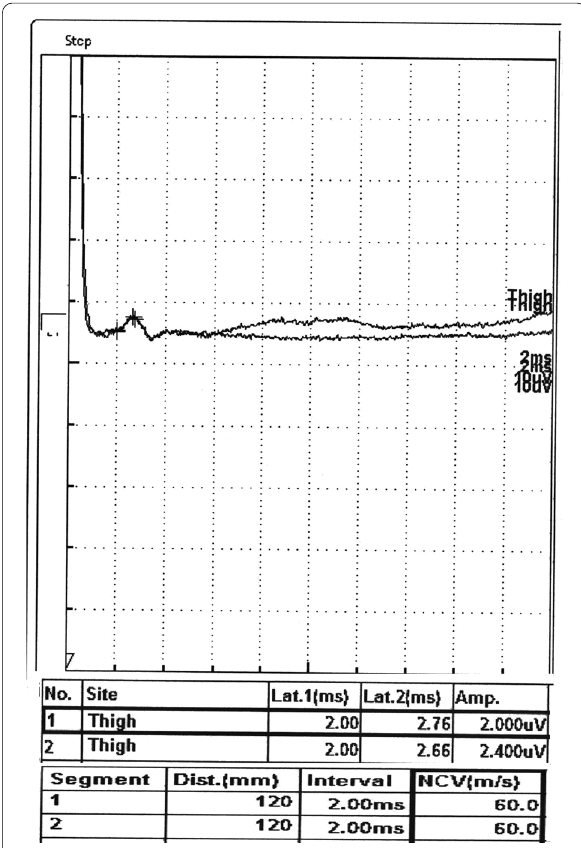
Fig. 5 Posterior femoral cutaneous nerve sensory nerve action potentials of an apparently healthy female participant. It is followed by volume-conducted motor potential obtained from hamstring muscles. Lat. 1, onset latency; Lat. 2, peak latency; Amp., amplitude; NCV, nerve conduction